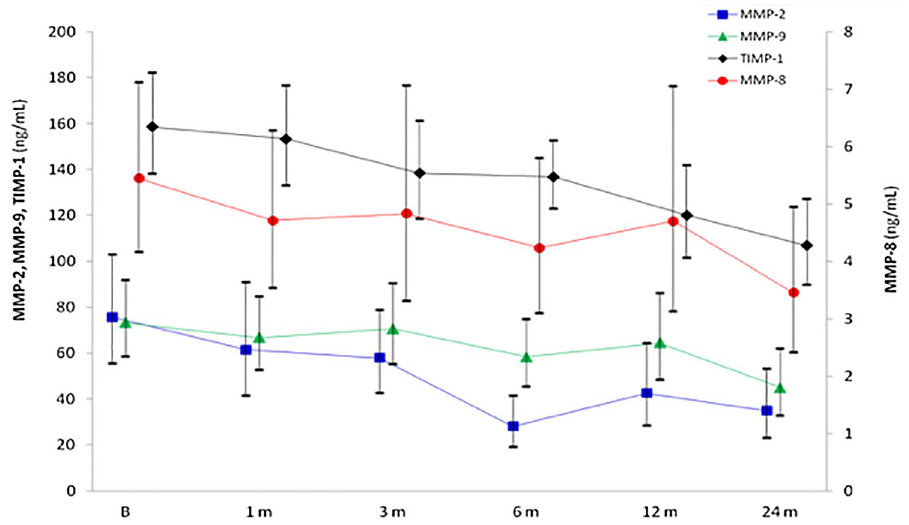
Figure 5. Course over time of MMPs and TIMP-1 (mean, 95% CI).